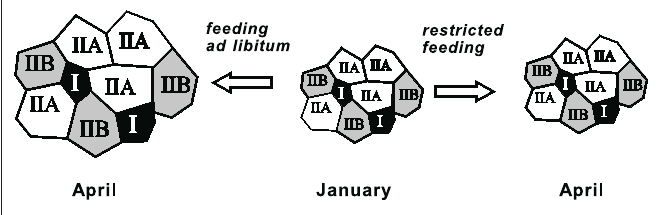
Fig. 5. Changes in cross sectional area in the middle gluteal muscle in reindeer calves. One group of calves was fed a pelleted feed ad libitum and the other group was fed lichens at 60% level of ad libitum